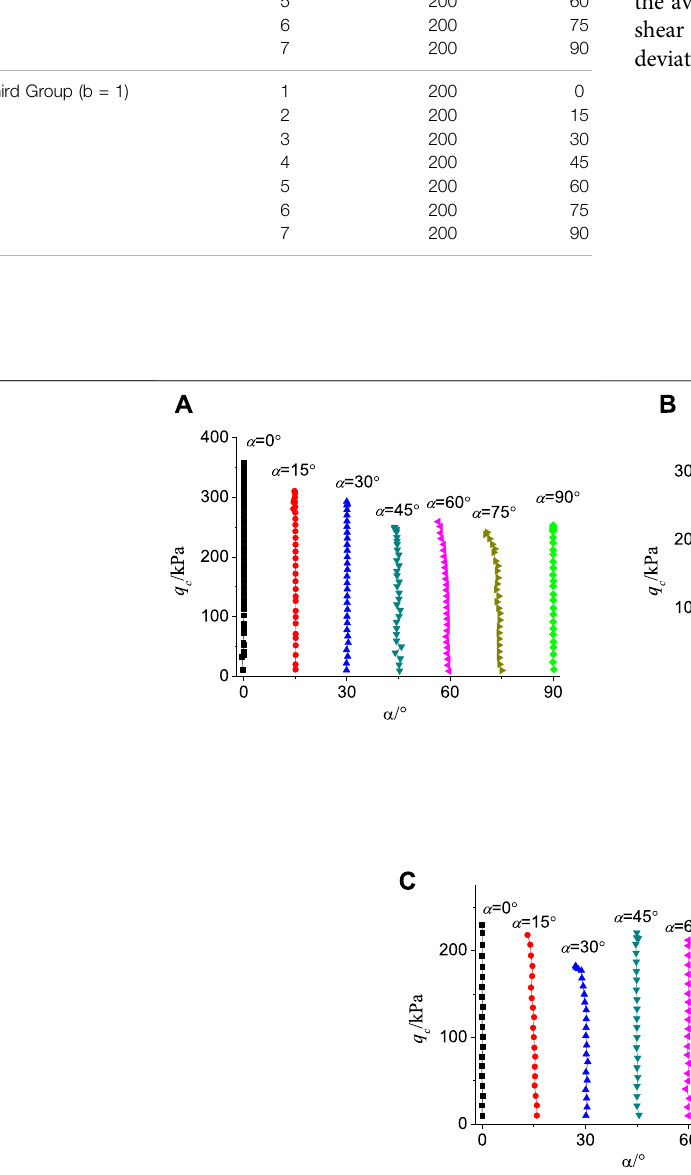
Frontiers in Earth Science |